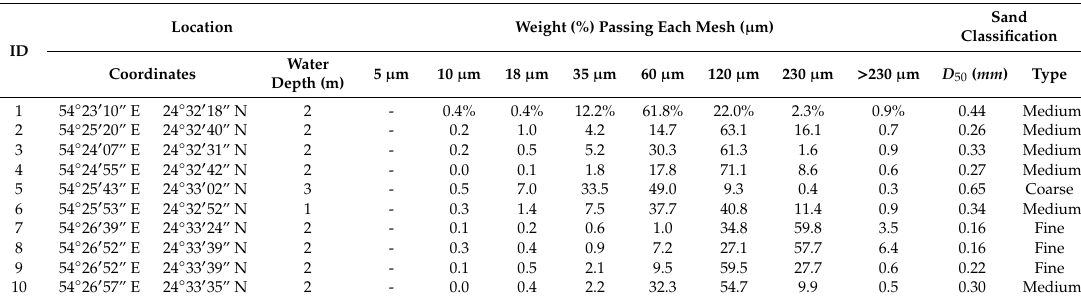
Figure 2. Location of sediment samples. Table 1. Sediment characteristics of Saadiyat beach: coordinates and water depths of collection points, sample weight percentages passing di ff erent meshes (of sizes 5 µ m, 10 µ m and so on), corresponding D 50 values and, finally, sand classification according to [6].